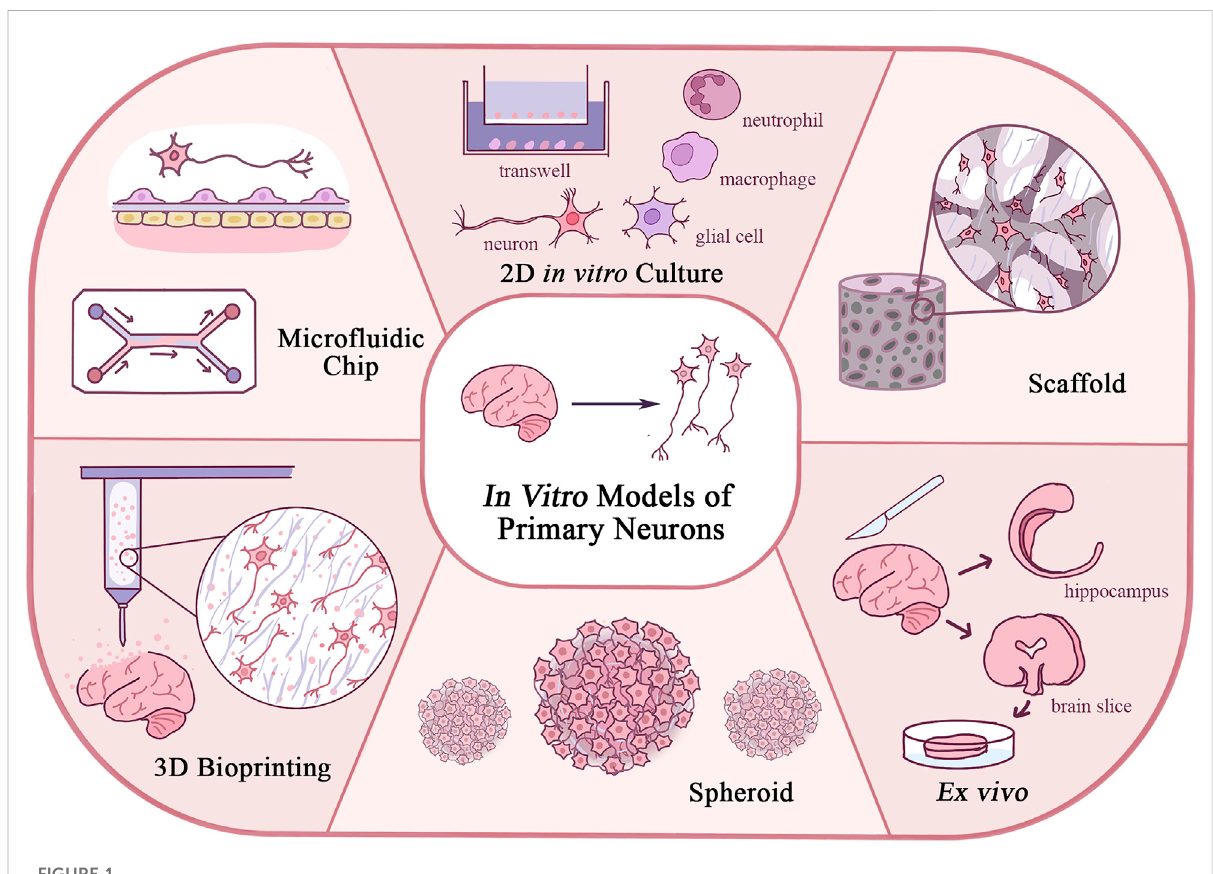
FIGURE 1 Schematic diagram of in vitro models of primary neurons illustrating features of each